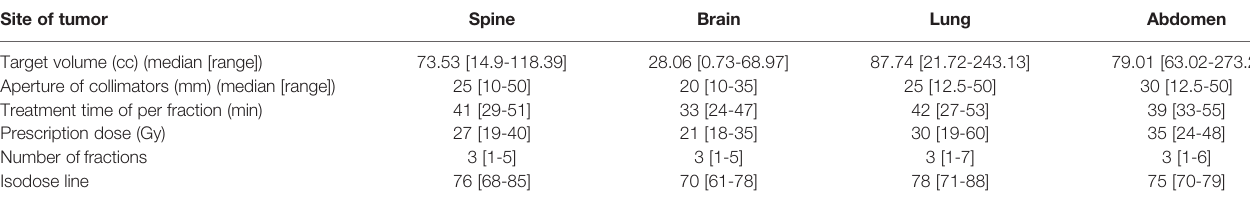
TABLE 1 | The target volume and aperture of collimators for all the DQA plans of different sites. Site of tumor Spine Brain